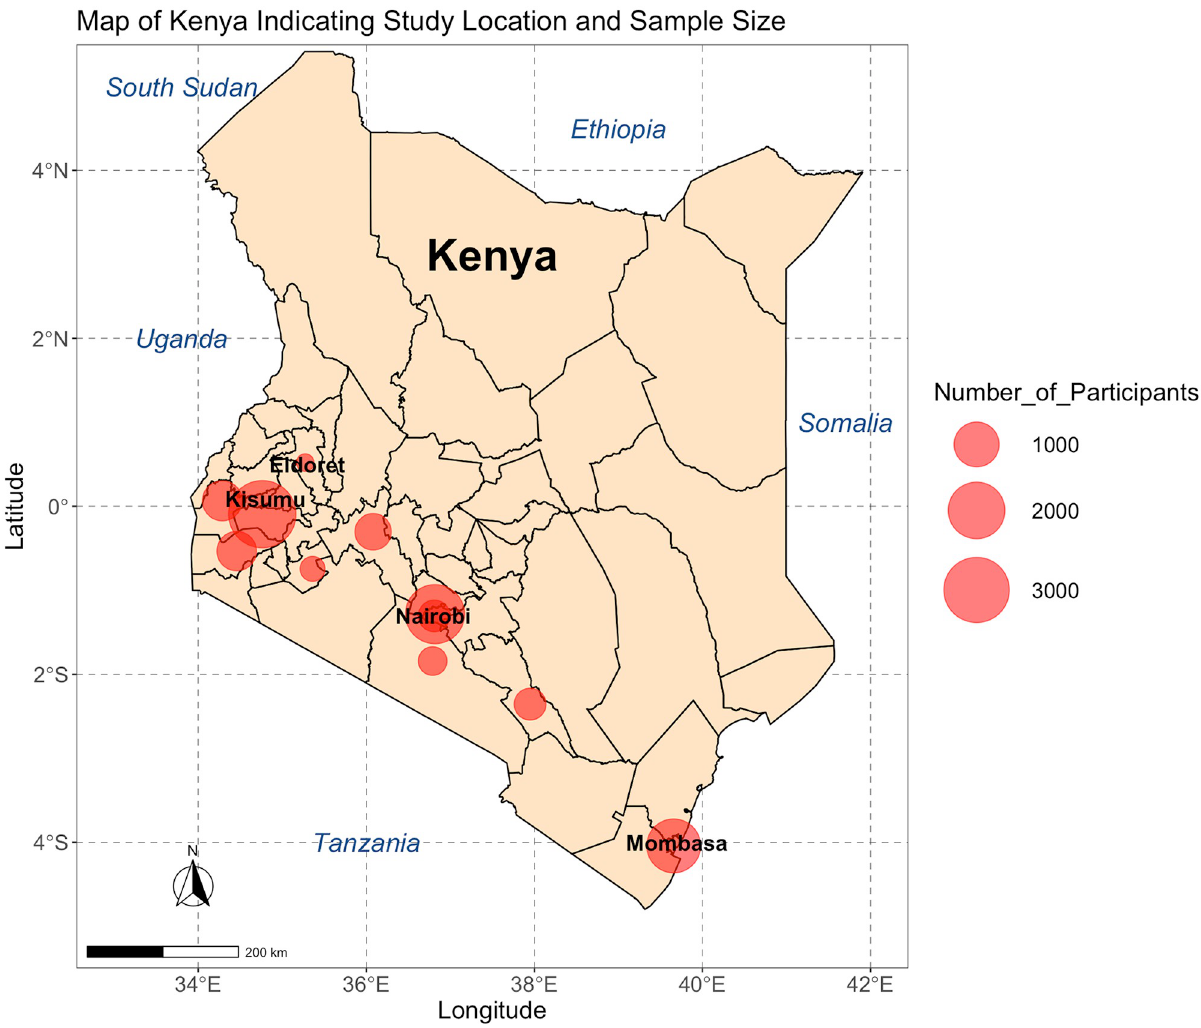
Fig 2. Map of Kenya indicating the locations and size of populations from which seroprevalence of HBV infection is reported. Data from a systematic review of papers reporting prevalence and genetic data for HBV in Kenya between 2000 and 2021. The size of the red circle indicates numbers screened in each location, studies in the same location are grouped together. n = number of individuals reported. Surrounding countries are marked in blue, Kenya’s four most populous cities are marked in black. Figure created using R version 4.2.0, packages ggmaps version 3.0.0, ggplot2 version 3.3.6 and sf version 1.0–7. The Kenyan county shapefiles were obtained from the Humanitarian Data Exchange, available open source from